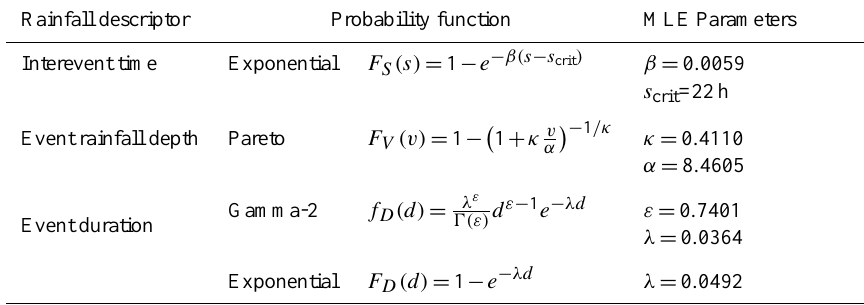
Table 4. Distribution functions and related MLE parameters for rainfall descriptors related to Valencia raingauge. Rainfall series was censored by excluding events whose rainfall depth is lower than 1mm. F and f indicate cumulative probability and the probability density, respectively. Note that an explicit formulation of F can not be provided for the Gamma-2 distribution.